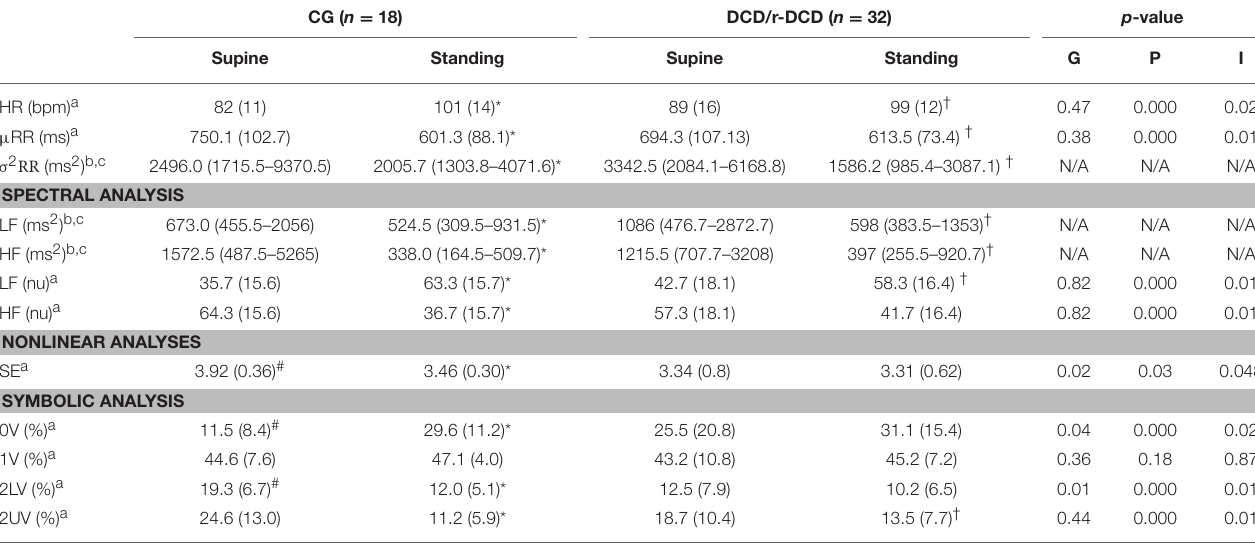
TABLE 2 | Linear and nonlinear heart rate variability indices of children with typical development (CG), and children at risk for Developmental Coordination Disorder (r-DCD) and those with DCD grouped together. CG ( n = 18) DCD/r-DCD ( n = 32) p -value Supine Standing Supine Standing G P I